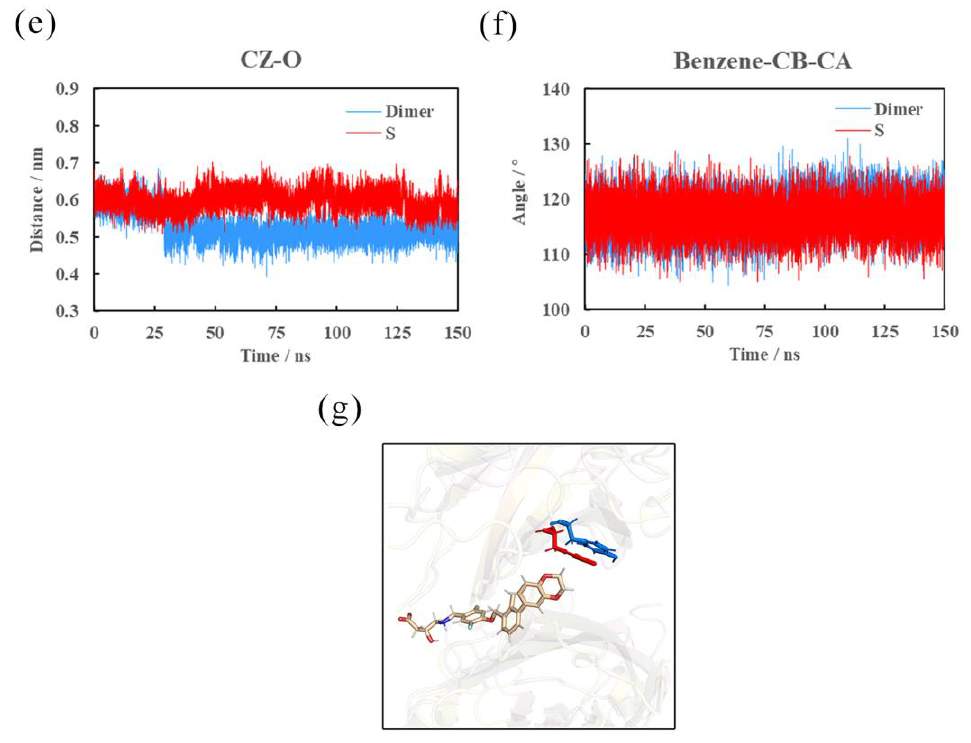
Figure 12. Structural comparison of A Y56 in the dimer and S systems. ( a ) ϕ in the dimer system. ( b ) ϕ in the S system. ( c ) ψ in the dimer system. ( d ) ψ in the S system. ( e ) CZ-O distance. ( f ) Benzene-CB-CA angle. ( g ) Overlap of A Y56. The dimer and S systems are shown in blue and red, respectively.